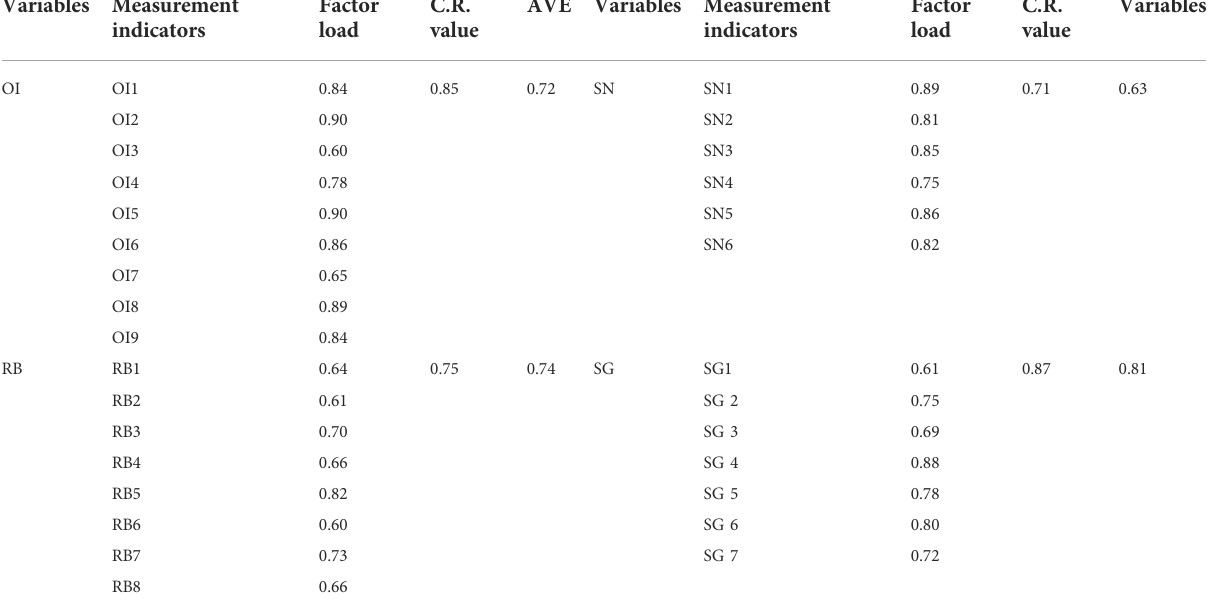
TABLE 1 Variable reliability test.